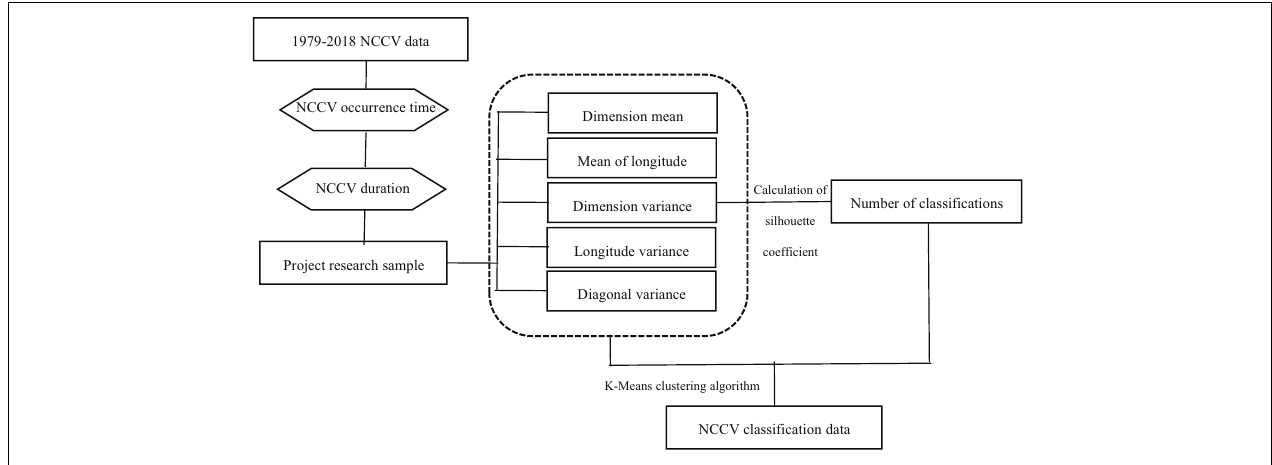
FIGURE 1 | Flow chart of the K-means clustering method for the NCCV path classifications.